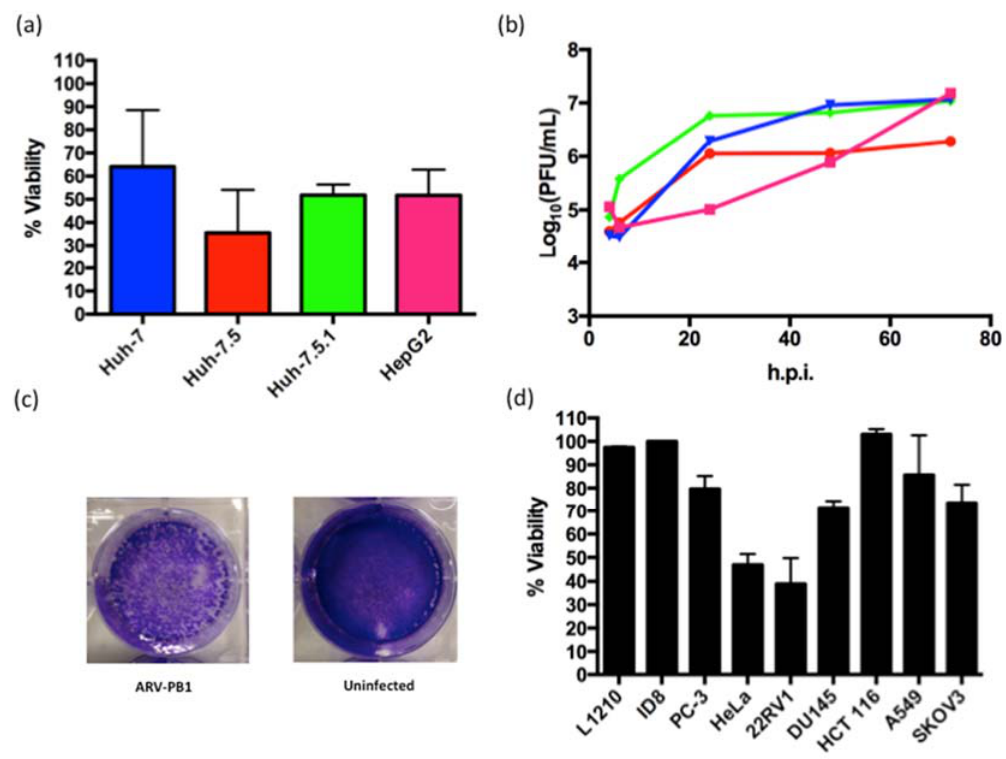
Figure 1. Evaluation of avian orthoreovirus (ARV-PB1) replication in cell lines. ( a ) Cell viability in human liver cell lines was measured at 96 hours post-infection (h.p.i.) with PrestoBlue TM Cell Viability Reagent (Life Technologies) and data was normalized to uninfected controls. Experiments for each cell line were performed a minimum of five times, and error bars represent the standard deviation. ( b ) ARV-PB1 titers at various time points, in cell lines following infection at a multiplicity of infection (MOI) of 5. The experiment was performed in duplicate and data are from one representative experiment. ( c ) Cytopathic effect following crystal violet staining in Huh-7.5 cells at 72 h.p.i. Similar results were observed in the other liver cell lines tested, which included Huh-7, Huh-7.5.1 and HepG2. Experiments were performed in triplicate, and one representative picture is shown. ( d ) Cell viability in other cancer cell lines infected at an MOI of 10 was measured at 96 h.p.i. with PrestoBlue TM Cell Viability Reagent (Life Technologies) and data was normalized to uninfected controls. The origin of the analyzed cell lines is described in Table S2. Experiments for the ID8 cell line was performed twice, all other cell lines were repeated a minimum of three times. Data represent the mean, and error bars represent the standard deviation.